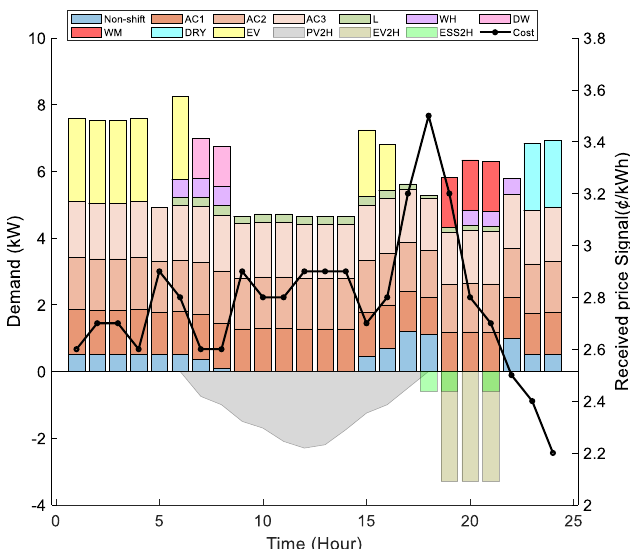
Figure 7. The impact of the power limiting (8-kW limit).